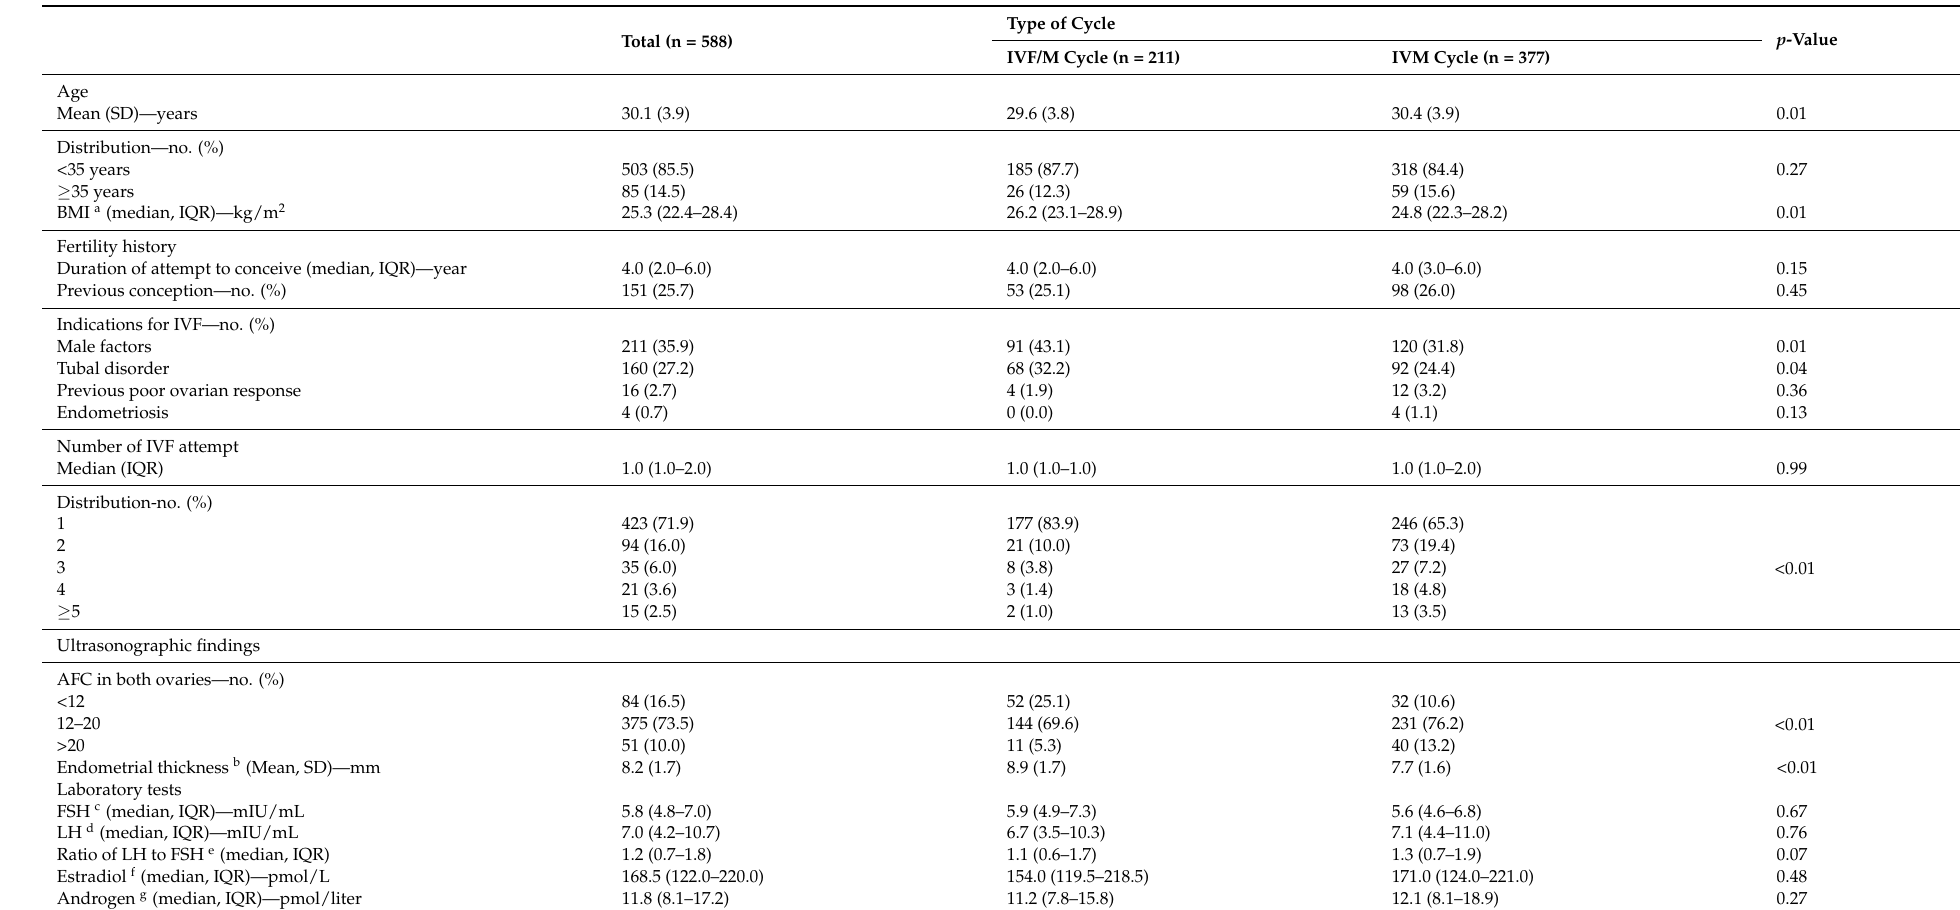
Table 2. Demographic and clinical characteristics of patients, by the natural or stimulation